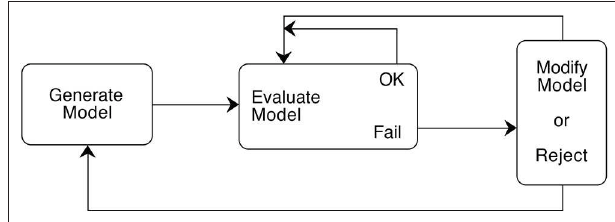
FIGURE 2 | GEM cycle of model generation, evaluation, and modification (adapted with permission from Clement, 1989, p.